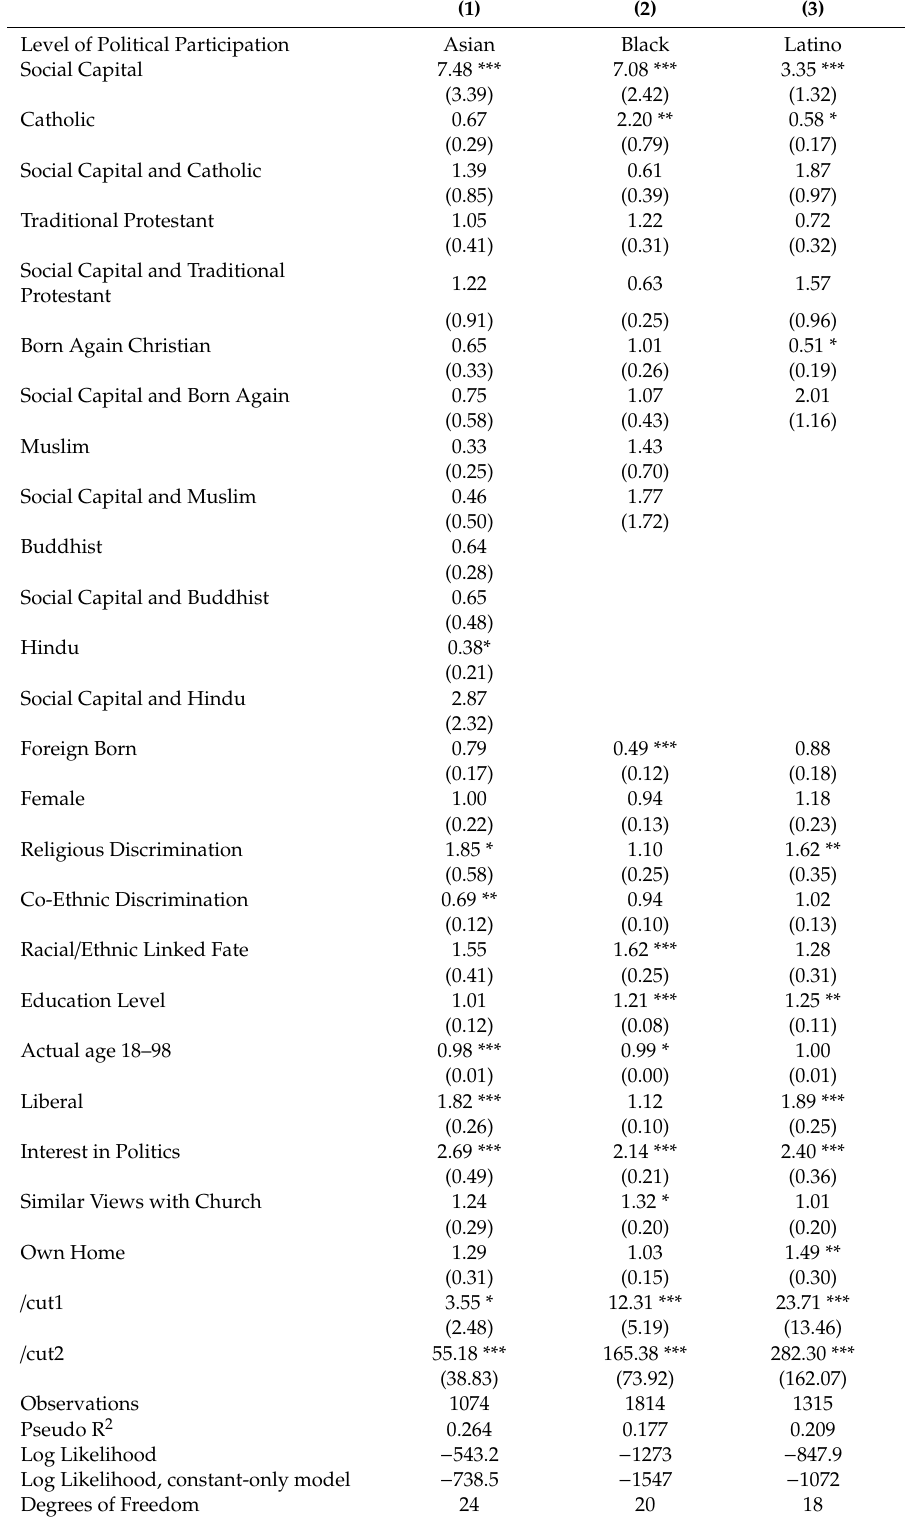
Table 5. Odds ratio of the e ff ect of social capital and tradition on political participation (with robust standard